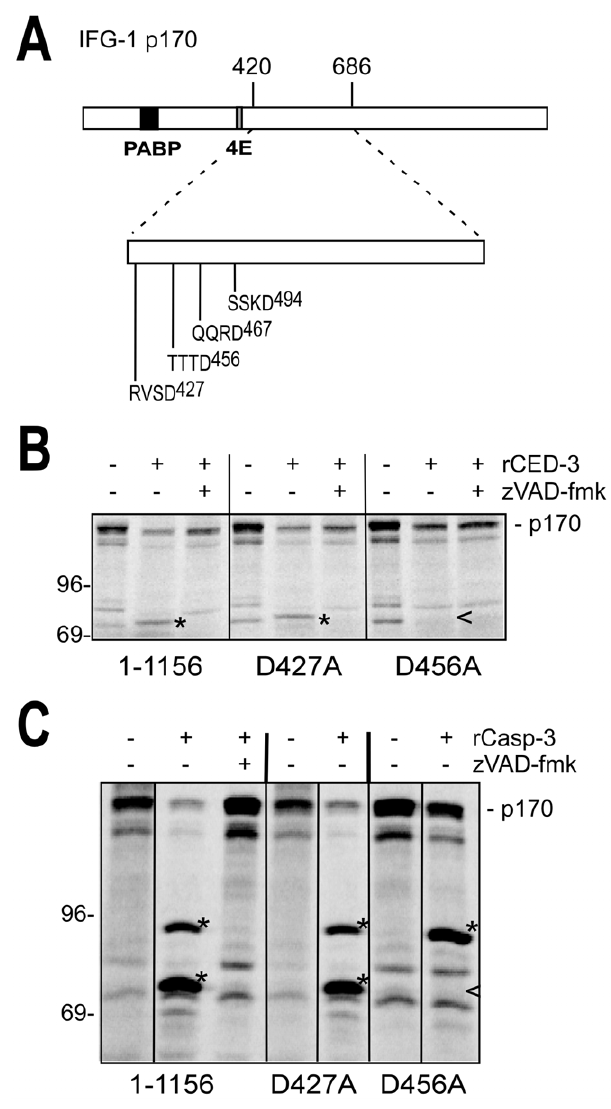
Figure 5. CED-3 cleaves IFG-1 p170 at Aspartate 456. (A) Diagram of full length IFG-1 depicting the rCED-3 cleavage region between amino acids 420 and 686. No canonical caspase 3 recognition sites (DXXD) are present in this region. The positions of the non- canonical caspase cleavage sites (XXXD) are shown. (B) and (C) Aspartates 427 and 456 were mutated to alanines in the context of full length IFG-1 (1–1156). Radiolabeled IFG-1 (1–1156) was incubated with either (B) C. elegans rCED-3 or (C) human rCasp-3, resolved by SDS- PAGE, and visualized by phosphorimaging. The (*) indicates processed fragments and a carrot ( , ) represents the absence of a processed fragment. IFG-1 D456A was resistant to cleavage by rCED-3, and abolished one of the two cleavages by